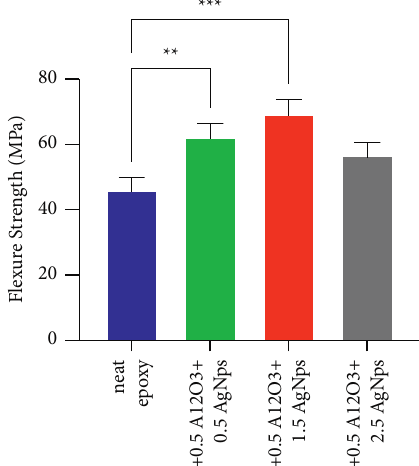
Figure 2: Flexure strength for pristine bioepoxy and bioepoxy reinforced by various weight fractions of Al 2 O 3 -AgNps. Asterisks indicate that results significantly different to the unmodified control ( ∗∗ p < 0 . 01; ∗∗∗ p < 0 . 001).